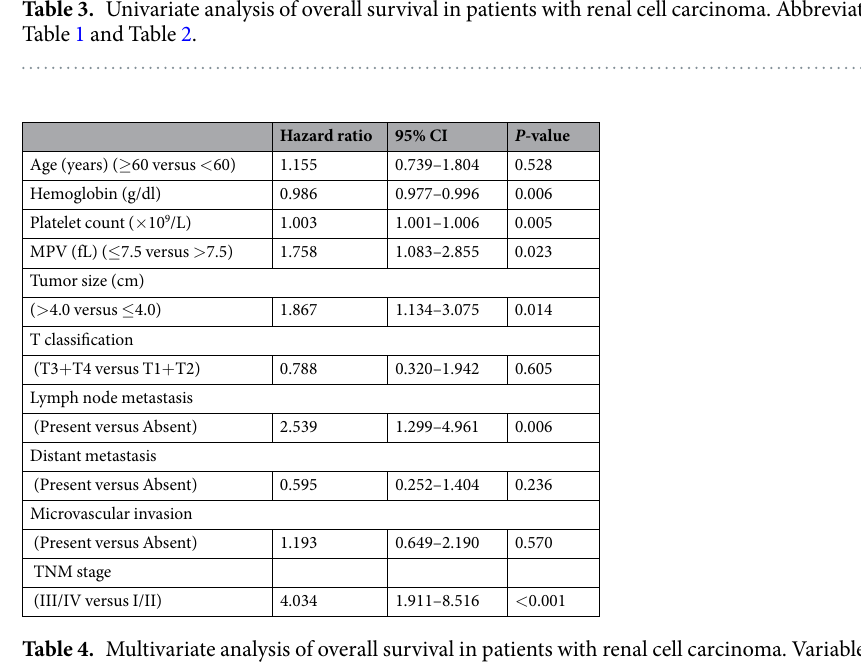
Table 4. Multivariate analysis of overall survival in patients with renal cell carcinoma. Variables that showed a p-value < 0.10 in univariate analysis were included in a multivariate Cox proportional hazards regression model. CI, confidence interval. Abbreviations: see to Table 1 and Table